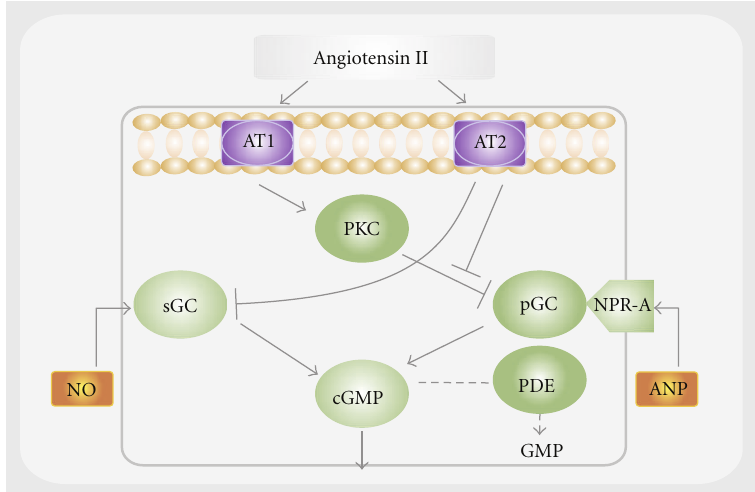
Figure 3: Schematic representation of the interaction between angiotensin II and guanylyl cyclase-dependent systems through AT1 and AT2 receptor in the podocyte. In podocytes, the guanylyl cyclase system may be modulated by angiotensin II via both AT1 receptor through pGC or AT2 receptor through sGC. In the absence of angiotensin II, both ANP and NO may also activate pGC and sGC, respectively. Abbreviations: cGMP: cyclic guanosine 5 (cid:2) -monophosphate; ANP: atrial natriuretic peptide; NO: nitric oxide; NPR-A: guanylyl cyclase- linked receptor for ANP; PKC: protein kinase C; sGC: soluble guanylyl cyclase; pGC: particulate guanylyl cyclase; PDE: phosphodiesterase. (Adapted from